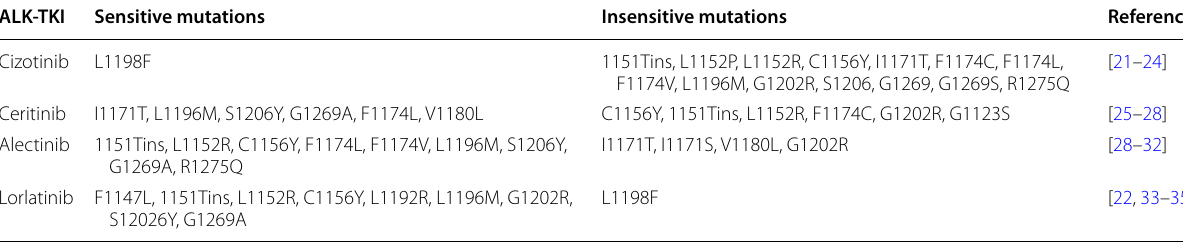
Table 2 The resistant mutations and sensitive mutations of ALK inhibitors ALK-TKI Sensitive